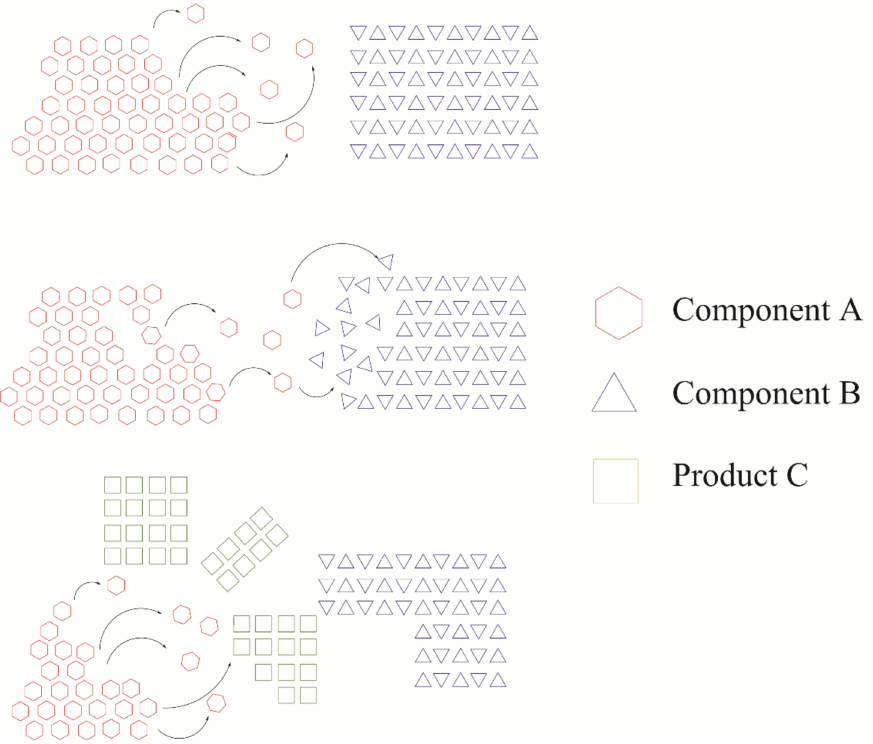
Figure 8. Schematic representation of cocrystal formation mechanism applying grinding/milling in a binary system. Adapted with permission from [117], American Chemical Society,